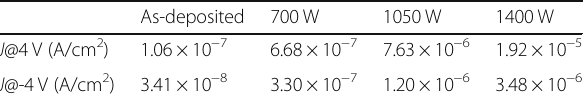
Table 1 The leakage current density ( J ) at ± 4 V for all the samples As-deposited